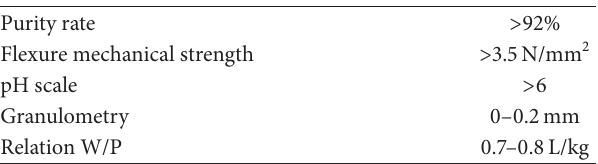
Table 2: Technical characteristics of the plaster used in the research [13].